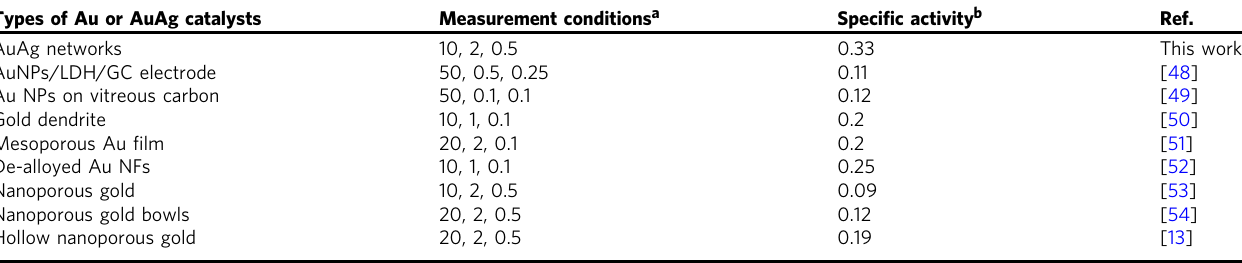
Table 1 Speci fi c activity of the Au and AuAg catalysts for the MOR reported in the literature Types of Au or AuAg catalysts